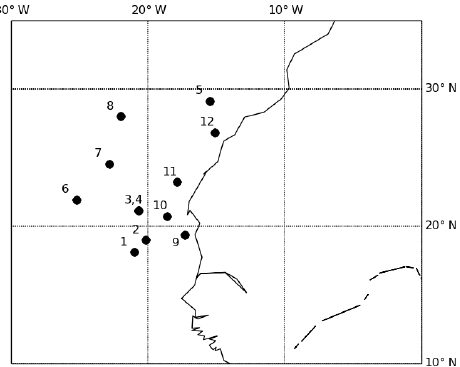
Figure 3. Site locations of marine sediment cores and sediment traps along the northwest African margin corresponding to Table